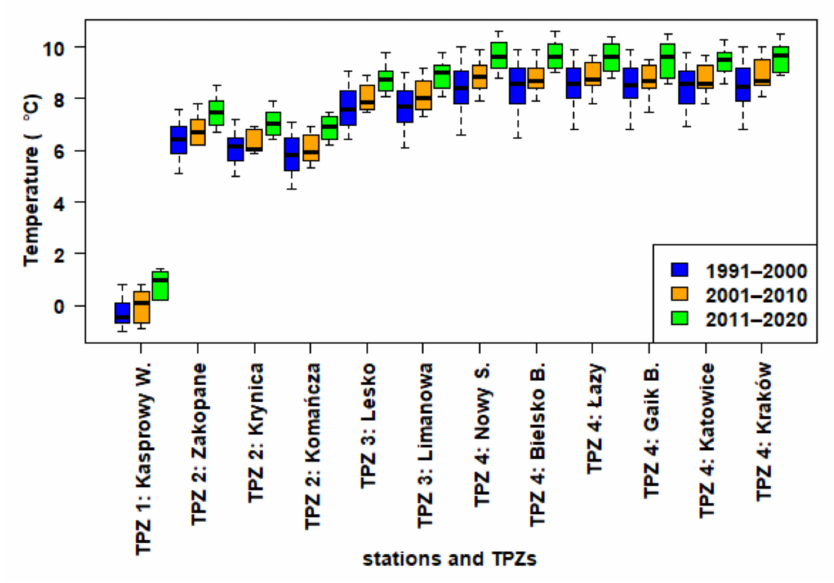
Figure 2. Mean annual air temperature ( ◦ C, black horizontal marks inside the boxes) in specific decades at the stations studied. Boxes mark the first and the third quartile, and the whiskers show the highest and the lowest value in a certain decade. Standard errors for the mean values are provided in Appendix C. Stations are ordered following the concept of TPZ explained in Section